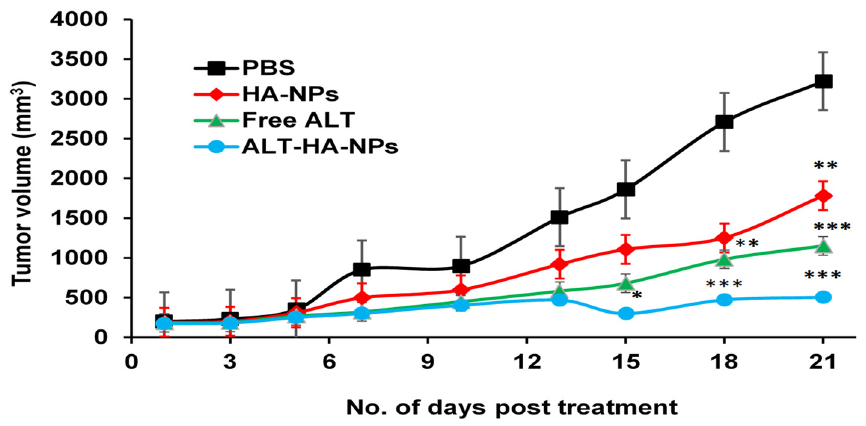
Figure 6. Anti-tumor activity of free ALT, ALT-HA-NPs, and blank HA-NPs (mean ± SD, n = 3). * significant compared to Control (PBS) group at p < 0.05, ** at p less than 0.01, *** at p less than 0.001